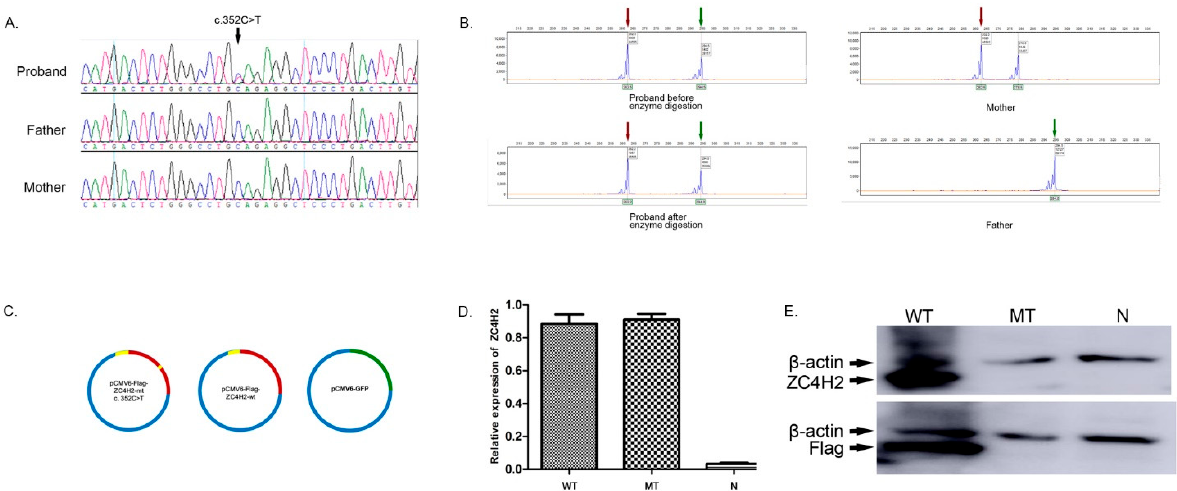
Figure 2. Characterization of the ZC4H2 de novo mutation (c.352C>T). ( A ) Identification of the de novo mutation with Sanger sequencing. The c.352C>T mutation in exon 3 of ZC4H2 was a de novo mutation identified only in the proband and not in her parents. ( B ) Analysis of X-chromosome inactivation. Two peaks of 262 and 294 bp were defined in the proband, indicating those inherited from her mother and father. The area under the peak inherited from the proband’s parents before enzyme digestion were 28,157 and 44,595, while those after enzyme digestion were 25,589 and 36,565, respectively. ( C ) Construction of the expression vectors. Wild-type and mutant proteins of ZC4H2 could be expressed in pCMV6-Flag-ZC4H2-wt and pCMV6-Flag-ZC4H2-mt c. 352C>T. The tagged protein (Flag) was inserted into the vectors, and the fusion protein was identified with antibodies targeting either Flag or ZC4H2. GFP was expressed by the normal control vector pLVHM-GFP, and therefore the transfection efficiency was determined by examining the fluorescence intensity. ( D ) Identification of relative expression levels of ZC4H2 by RT-qPCR. The relative expression levels of ZC4H2 were found to be 0.88 ± 0.058 and 0.91 ± 0.034, respectively. No significant differences were therefore identified between the two groups ( p = 0.72). ( E ) Identification of the ZC4H2 protein in the 293T cells. Western blotting results showed that ZC4H2 and Flag could be detected in the cells transfected with pCMV6-Flag-ZC4H2-wt, whereas these were not seen in the cells transfected with pLVHM-GFP or pCMV6-Flag-ZC4H2-mt c. 352C>T. By contrast, β -actin was detected in